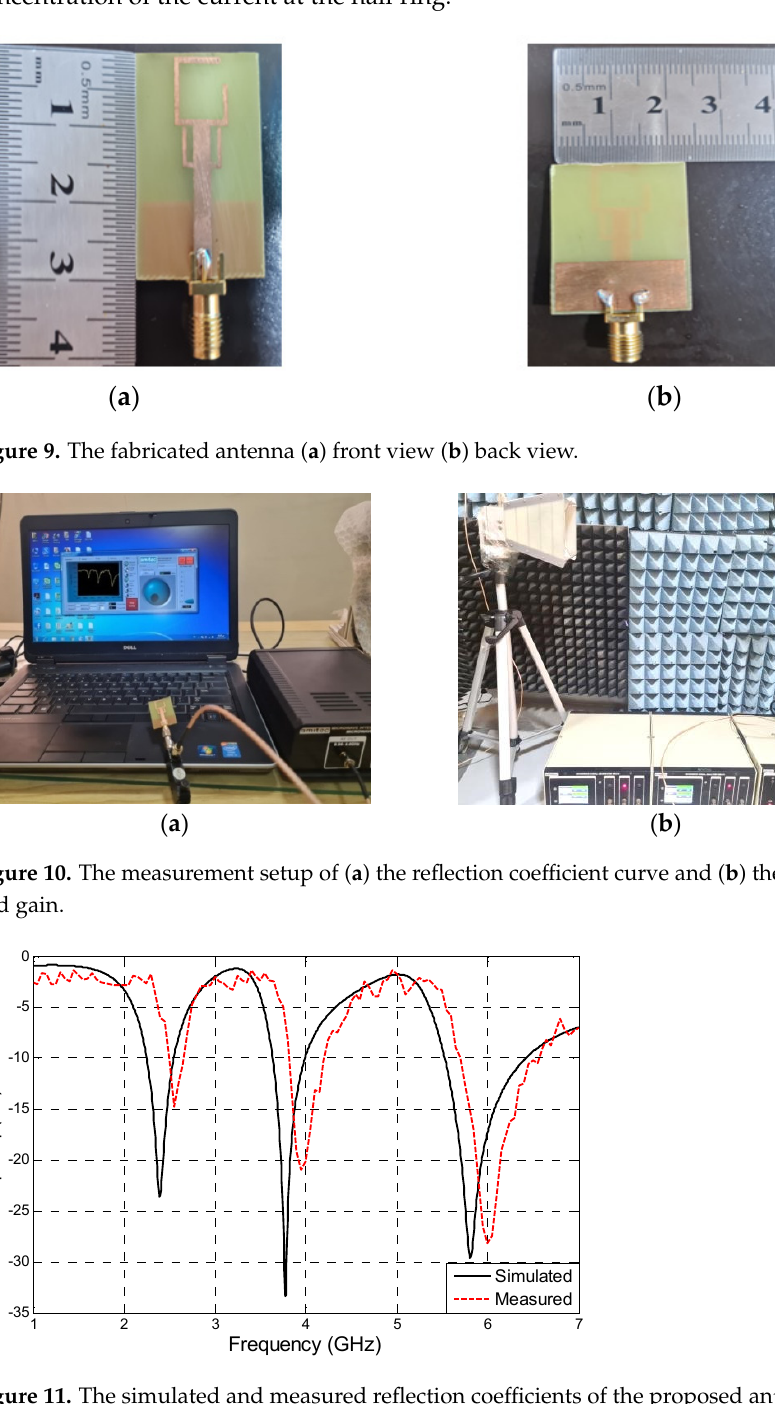
( b ) ( c ) Figure 12. The simulated current distribution of the proposed design at ( a ) 2.4 GHz, ( b ) 3.7 GHz, and ( c ) 5.8 GHz. The simulated and measured normalized power patterns of the final structure at the three resonant frequencies are shown in Figure 13. The E-plane and H-plane patterns are bidirectional and omnidirectional, respectively, for all of the three bands, which is almost preferable for the IoT portable devices. According to these patterns, the radiation for each frequency is independent of the orientation of the IoT devices so that it facilitates the con- nection of the antenna with the other IoT devices. Figure 14 shows the variation of the simulated and measured gain values as a function of frequency for the three bands (2.25– 2.55) GHz, (3.6–3.99) GHz, and (5.5–6.4) GHz. The maximum simulated and measured gain values are found to be equal to 1.6 dBi and 1.43 dBi, for 2.4 GHz and 2.55 GHz, re- spectively. The other two bands have maximum measured gain values of 0.9 dBi and 1.1